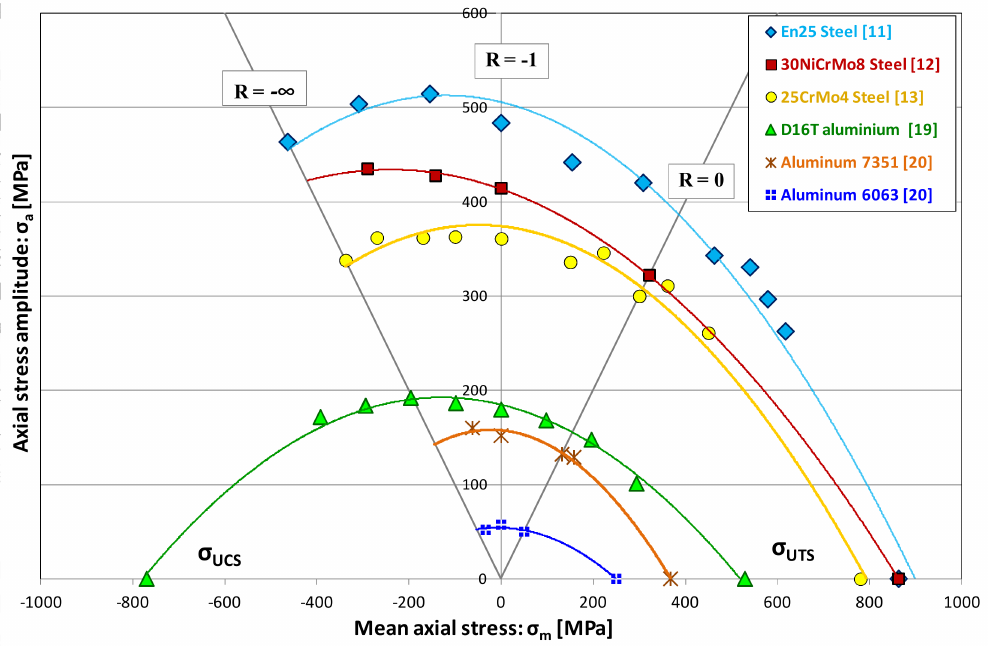
Figure 2. Haigh diagram with ductile materials [11–13,19,20] with tensile and compressive mean stresses, showing concave downward shapes for all the tested materials from